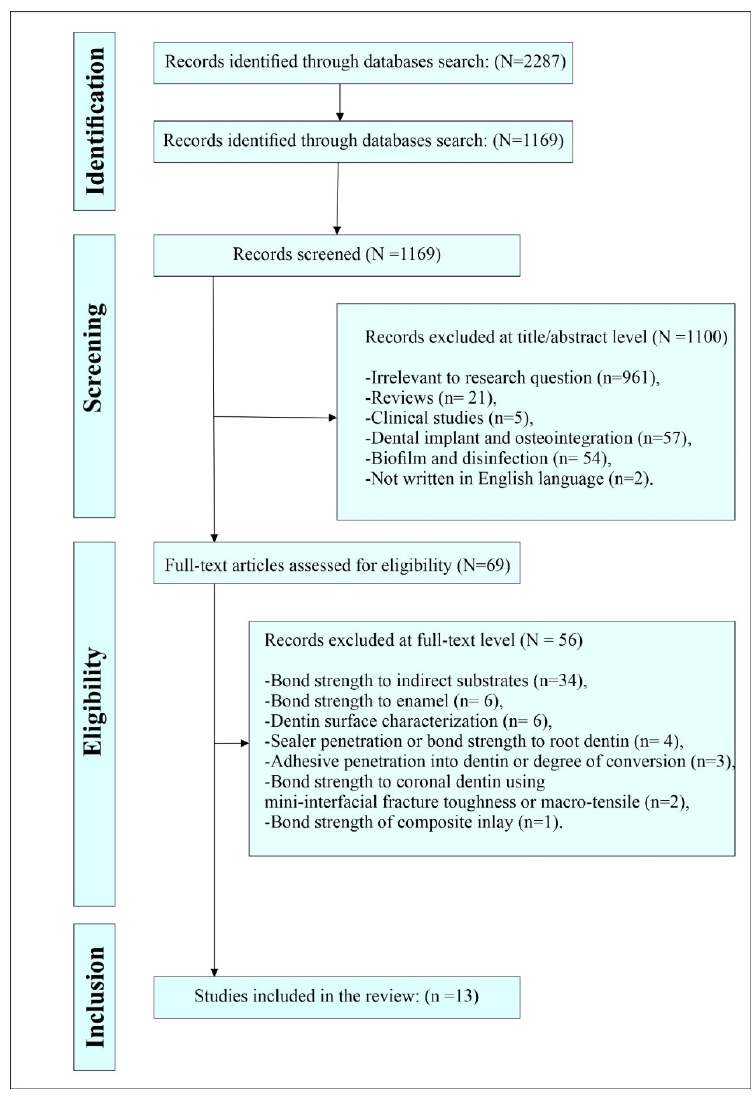
Figure 1. Search flowchart as adapted from the Preferred Reporting Items Systematic Review and Meta-Analysis (PRISMA) statement